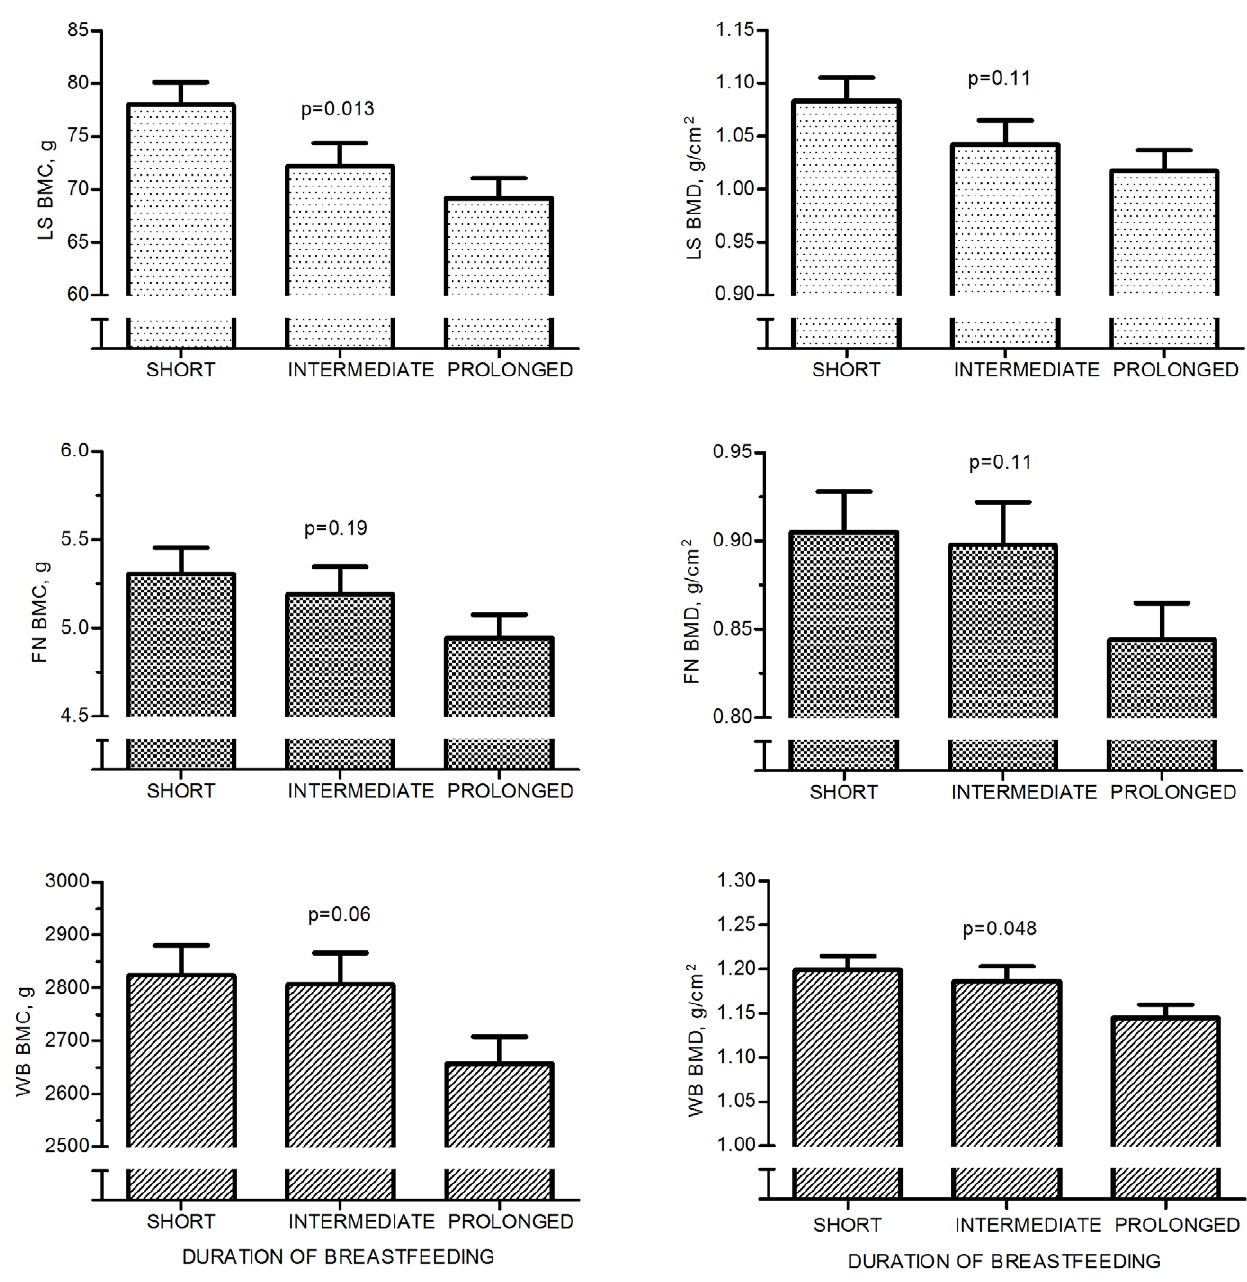
Figure 1 . BMD and BMC in the different feeding groups in males . Covariates used were current weight, daily intake of calcium and physical activity at adolescence. BMD = bone mineral density; BMC = bone mineral content; BF = breast feeding (Short # 3 mo; Intermediate . 3 mo, but , 7 mo; Prolonged $ 7 mo); LS = lumbar spine; FN = femoral neck; WB = whole body.